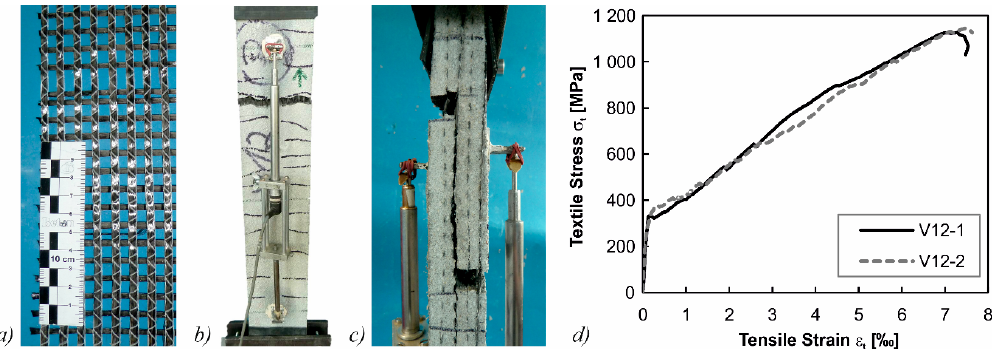
Figure 8. ( a ) Unimpregnated carbon textile; ( b ) tensile test setup; ( c ) pull-out of rovings after failure; and ( d ) stress-strain relationships of tensile tests with an un-impregnated carbon grid. Table 3. Mean values of maximum textile stresses in the tensile tests for different textile materials and sprayed mortars.